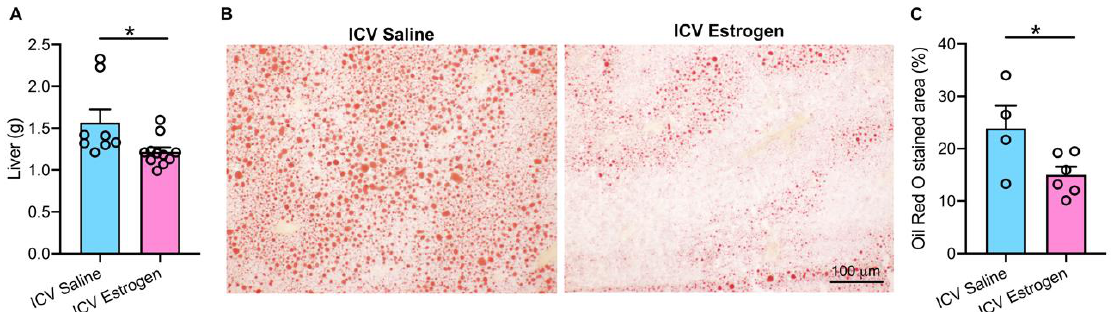
Figure 4. Central supplementation of estrogen in obese male mice alleviates hepatomegaly and hepatic steatosis. ( A ) Liver weight (n = 8 – 11), ( B ) representative hepatic Oil-Red-O staining, and ( C ) quantitative analysis of Oil-Red-O-stained area (n = 4 – 6) following 6-day administration of ICV 17- β -estradiol or saline control in obese male mice. * p < 0.05 vs. ICV Saline.